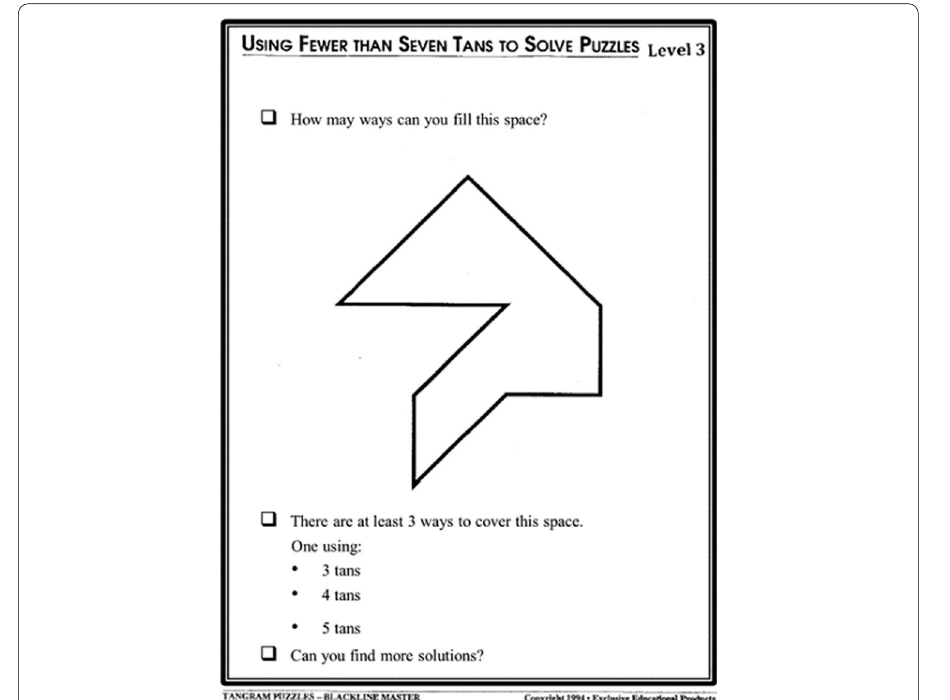
Fig. 6 Challenge Level 3 Sheet for Stage 4 taken from Tangram Blackline Masters (1994)